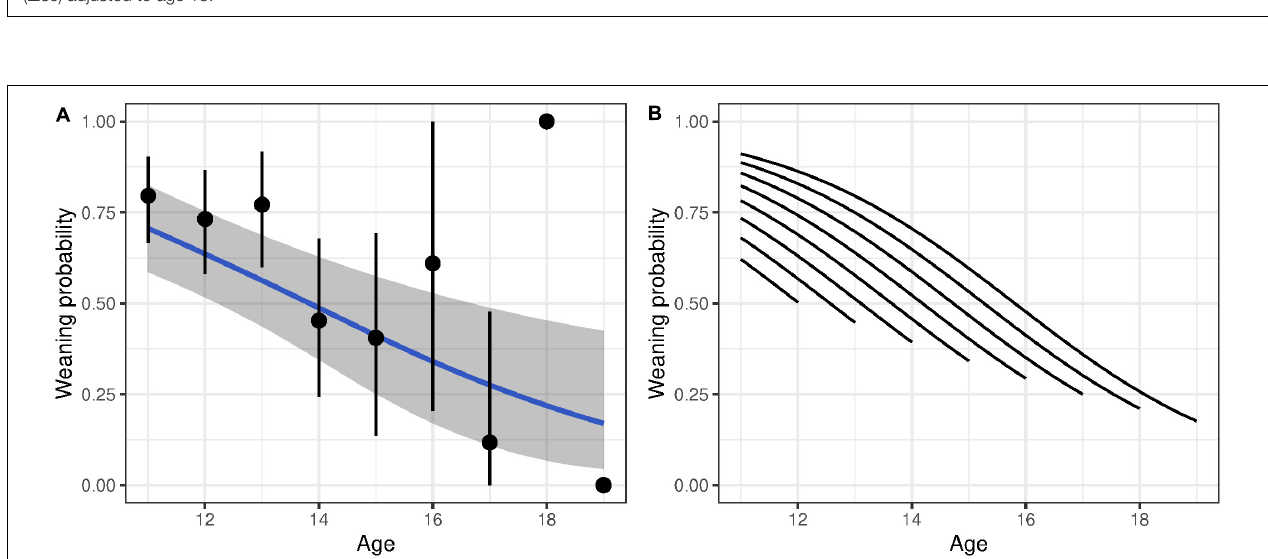
FIGURE 2 | Probability of weaning a lamb as a function of age for bighorn females. (A) Shows age-specific probability without accounting for longevity. The blue line shows predicted weaning probability with associated 95% CI given a linear decline in weaning probability with age. The points show average age-specific values ( ± 95% CI). (B) Shows the change in weaning success with age decomposed into the effect from within-individual change with age and from selective disappearance. Each line shows the average within-individual change with age of individuals grouped by longevity.